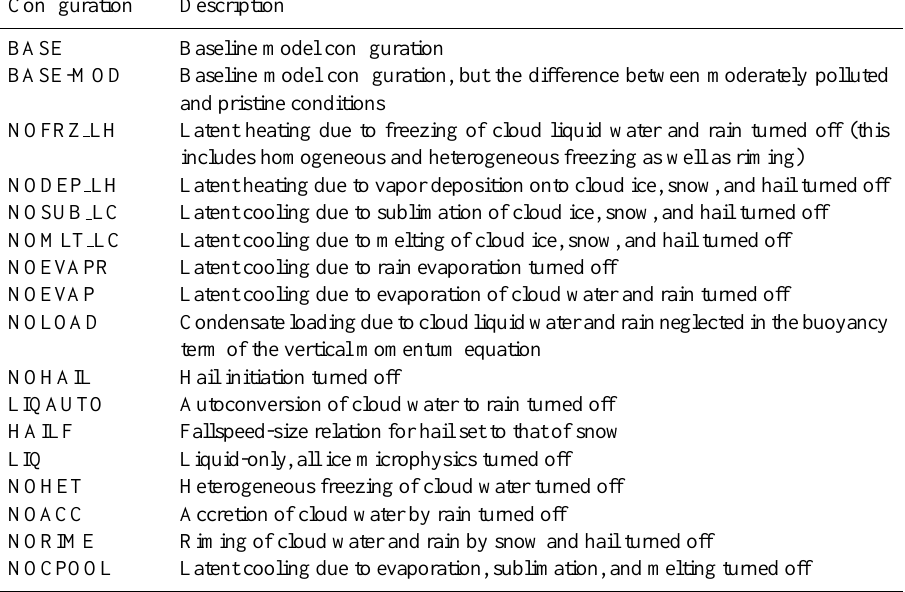
Table 1. List of all model configurations tested.